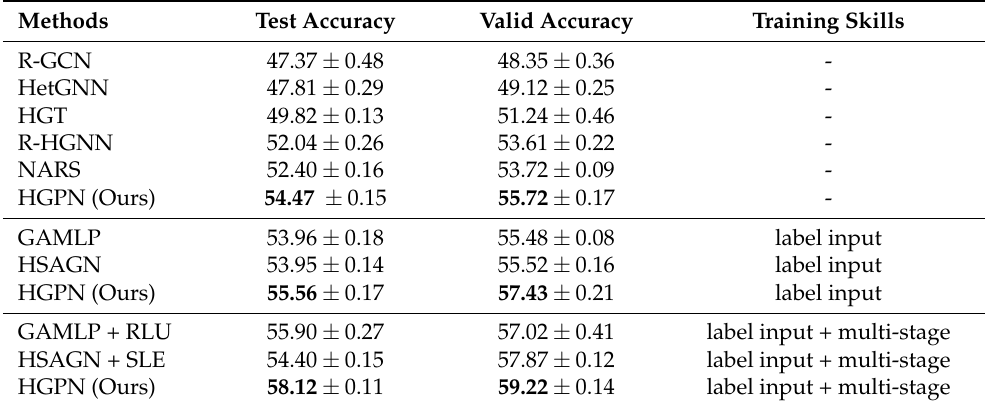
Table 3. Overall performances on OGB-MAG dataset. The numbers in bold mean the best results. Vacant positions (“-”) mean that the method does not adopt any additional training skills. We run each method 10 times and report the average